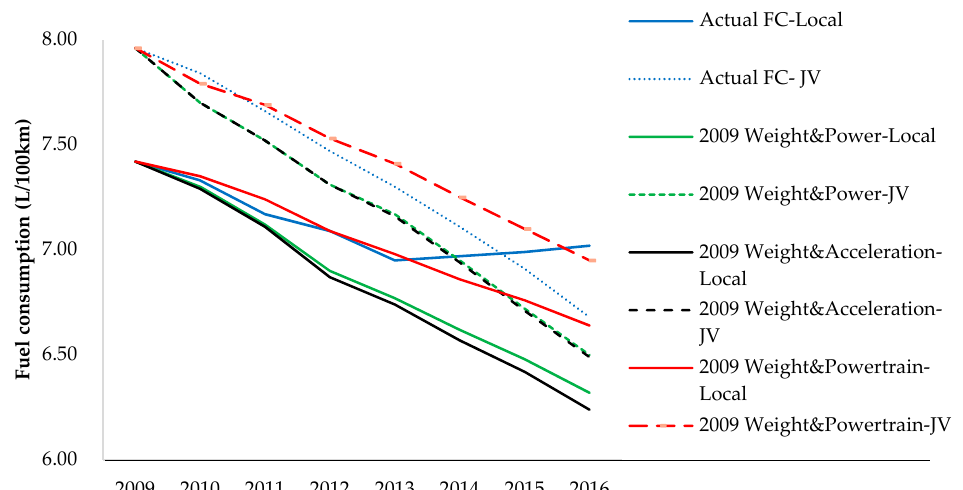
Figure 6. Actual FCR of average new passenger vehicles, and potential FCR if various attributes had remained at 2009 levels for local and joint venture brands.